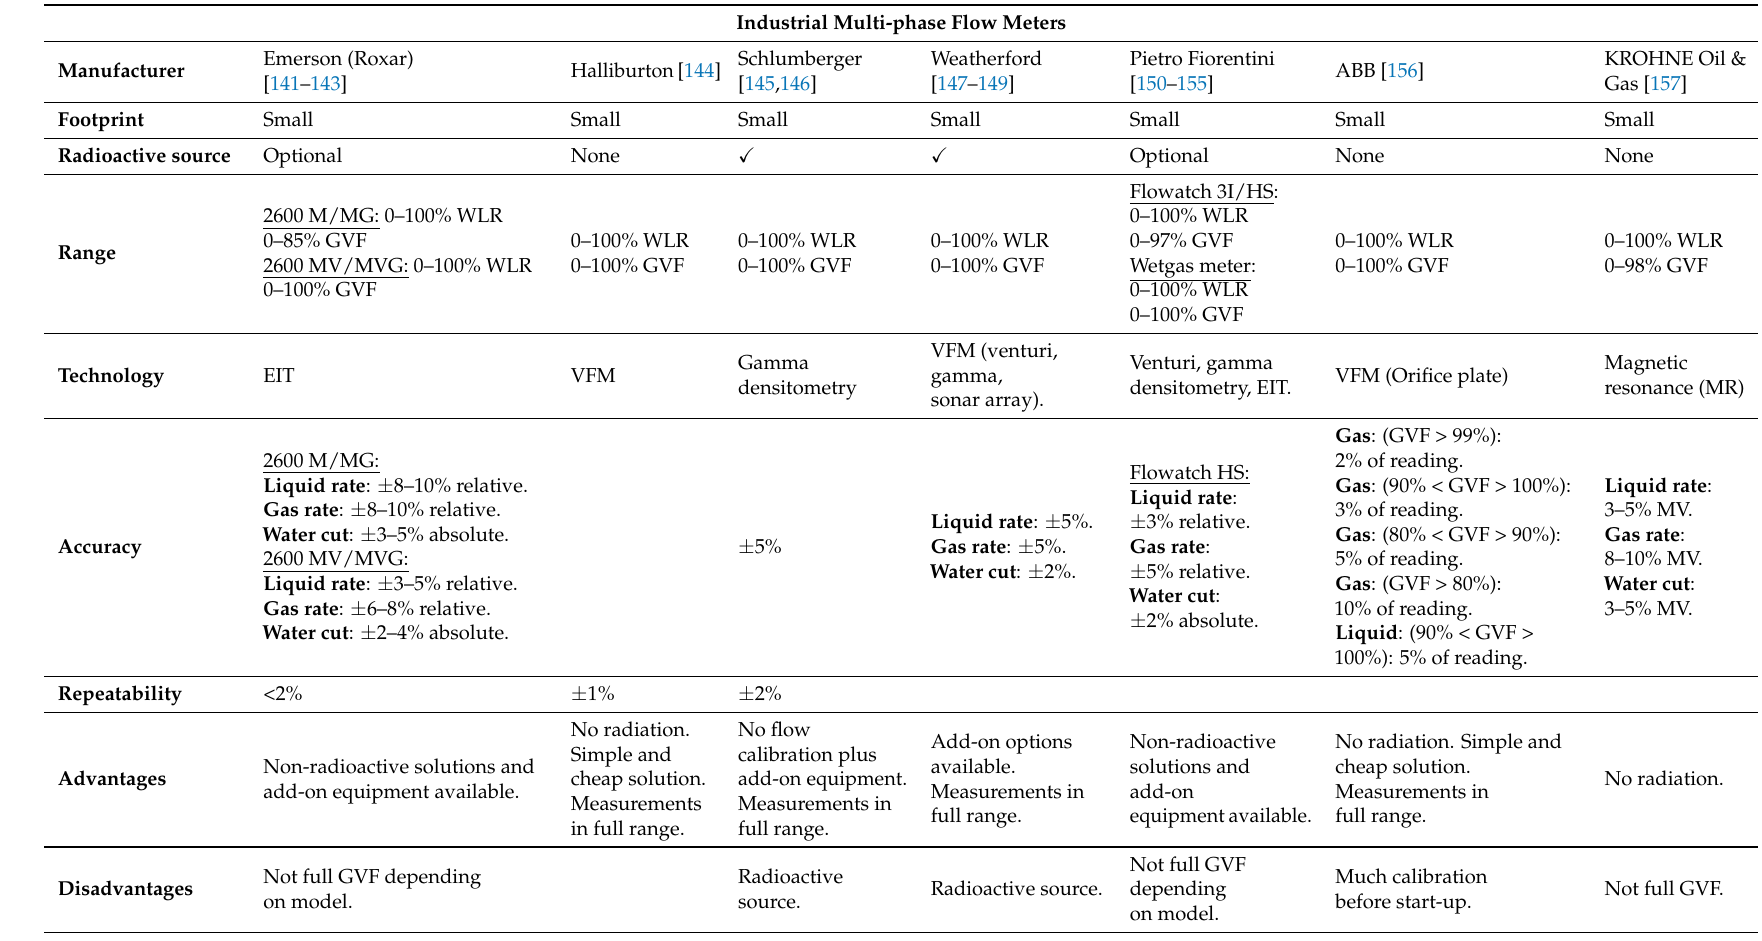
Table 2. List of industrial multi-phase flow